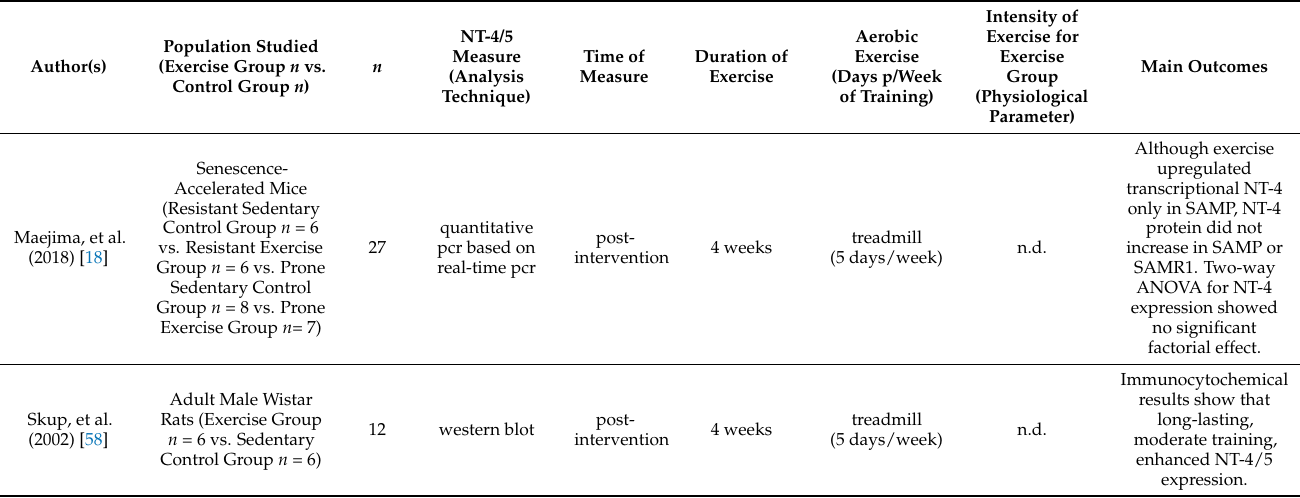
Table 3. Summary of studies that have reviewed the relationship between a chronic aerobic exercise intervention and the variation of NT-4/5 blood concentration levels in animal